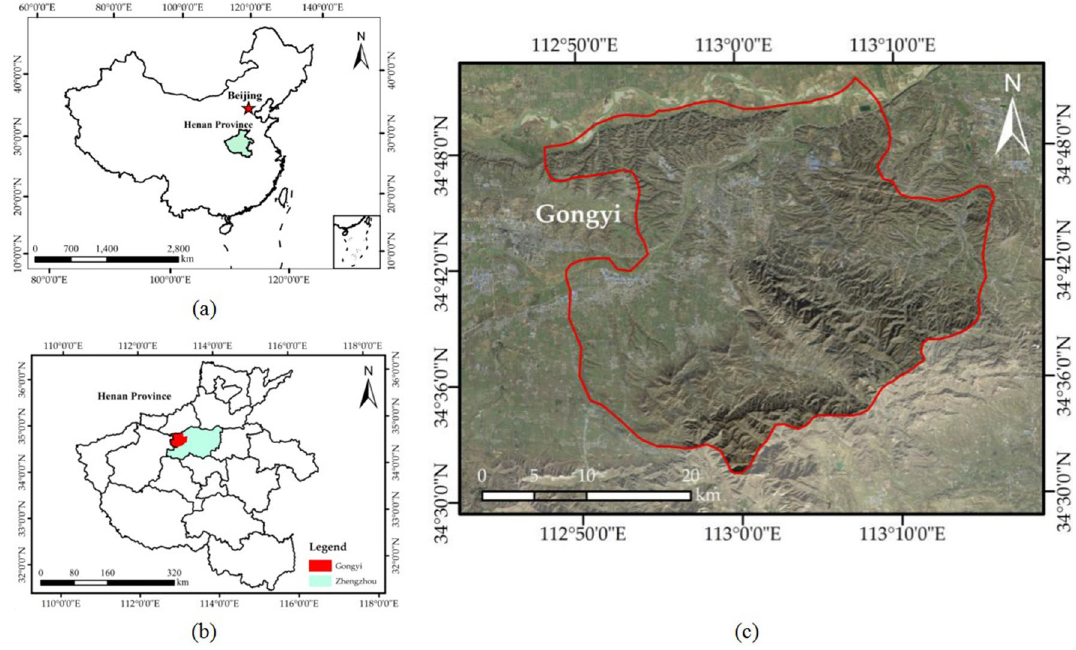
Figure 1. Location of the study area in China. ( a ) Map of China; ( b ) map of Henan Province; and ( c ) Gaofen-2 (GF-2) satellite image (http:// www. hbeos. org. cn/) showing the location of Gongyi. The Figure is created using ArcGIS ver.10.3 (https:// www. esri.